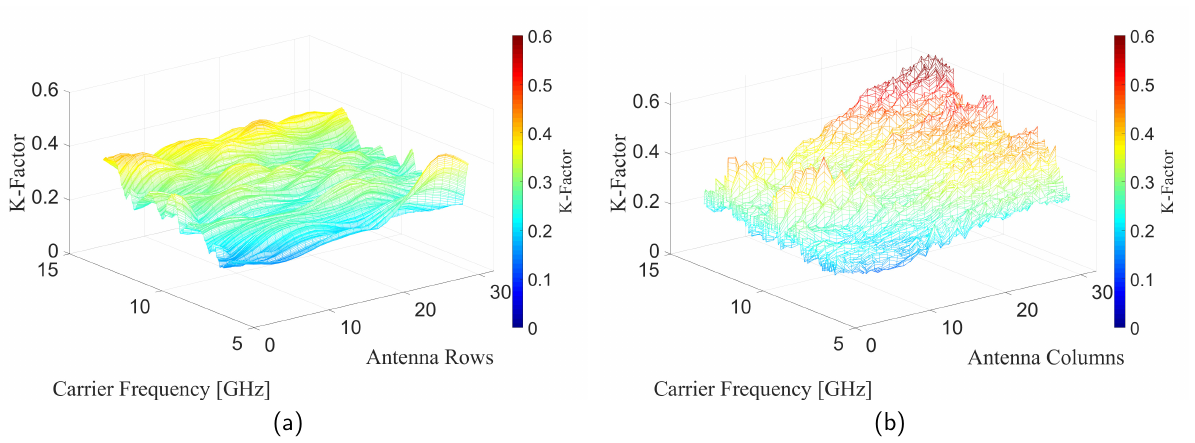
Figure 12. The K-Factor versus carrier frequency and antenna elements at Position 2. ( a ) The K-Factor in different rows. ( b ) The K-Factor in different